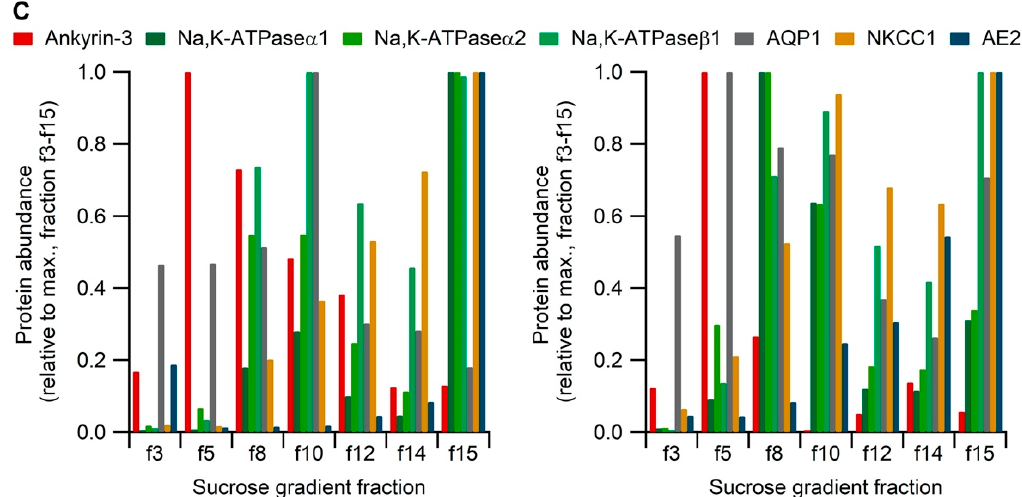
Figure 3. Variation in sub-cellular profiles of CP proteins assessed by differential centrifugation. ( A ) Immunoblots of the sedimentation profiles of CP proteins from 5–20% and 5–30% sucrose gradients. Targeted proteins are indicated below the blots. Molecular sizes are shown on the left (kDa) and fraction numbers are shown above the immunoblots. P: Pellet; S: Supernatant. Below the blots, cartoons are indicating the density from low (left) to high (right). The experiment was repeated for both gradients. ( B ) Densitometric analysis of immunoblots showing each protein abundance relative to the respective maximal abundance observed in fraction 3–16 from 5–20% sucrose gradients (left panel) or from 5–30% sucrose gradients (right panel, n = 2). Fraction 16 is plasma membrane enriched. ( C ) Similar analysis showing each protein abundance relative to the respective maximal abundance observed in fraction 3–15 from 5–20% sucrose gradients (left panel) or from 5–30% sucrose gradients (right panel, n = 2).